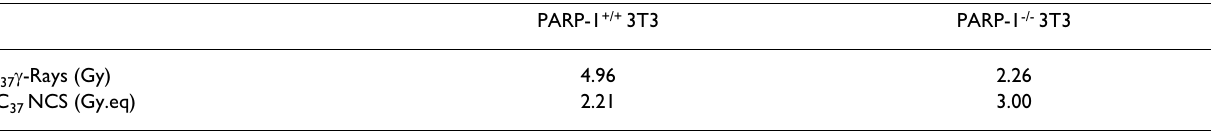
Table 1: Comparison of the mean lethal dose D 37 (or LC 37 ), i. e., the radiation dose (or NCS concentration) leaving 1/e = 37% survival, among the two cell lines